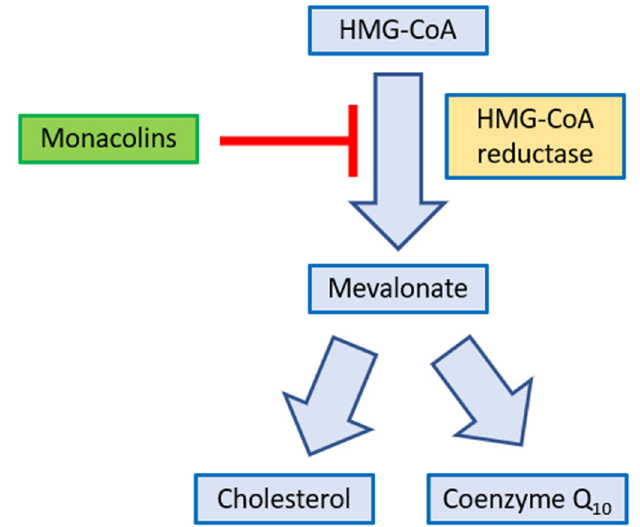
Figure 9. Hypolipidemic mechanism of action of monacolins.